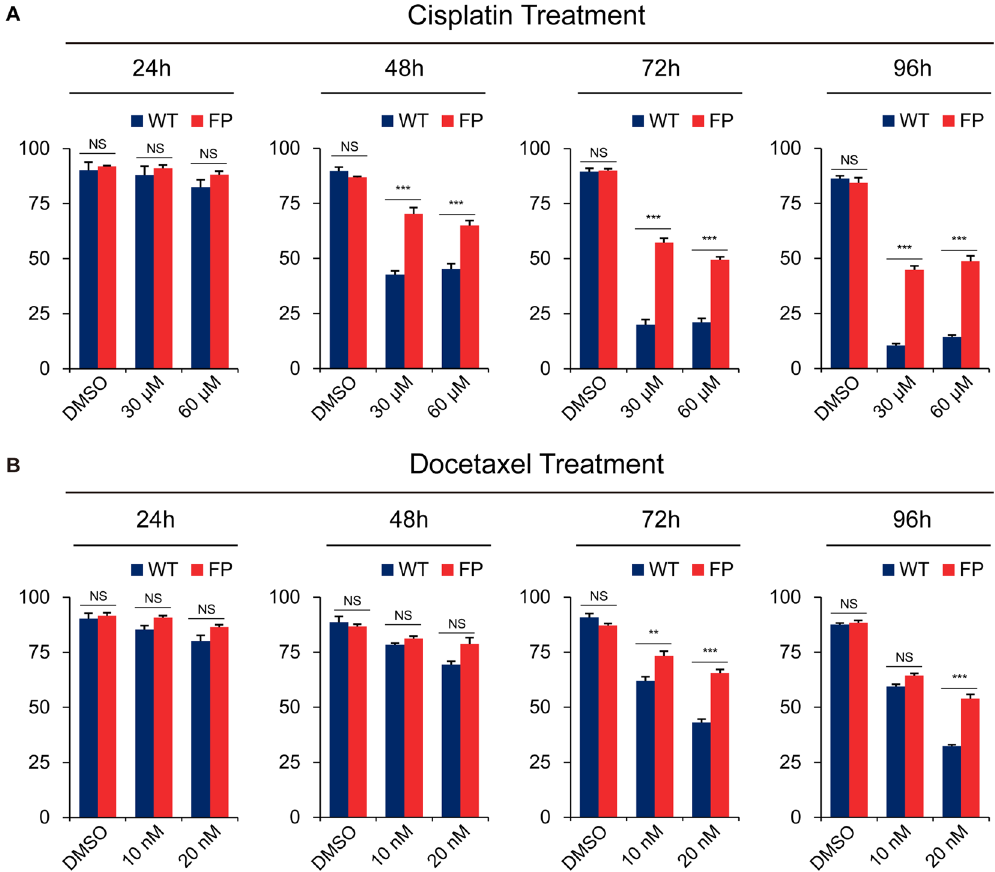
Figure 5. DU145 FP cells are less sensitive to cisplatin and docetaxel-induced apoptotic pressure. ( A ) The cisplatin and ( B ) docetaxel treatments were applied to the cells for 24–96 hours to evaluate the efficacy of apoptosis induction. The subpopulations’ double negative phenotype for Annexin V-FITC and PI staining were considered as viable (see Supplementary Material). The numbers of viable cells were collected, and displayed in the histograms. The data is presented as means from four independent experiments (mean ± SEMs. one- way ANOVA analysis was applied with Bonferroni method). Statistical significance: * p < 0.05, ** p < 0.01, *** p <